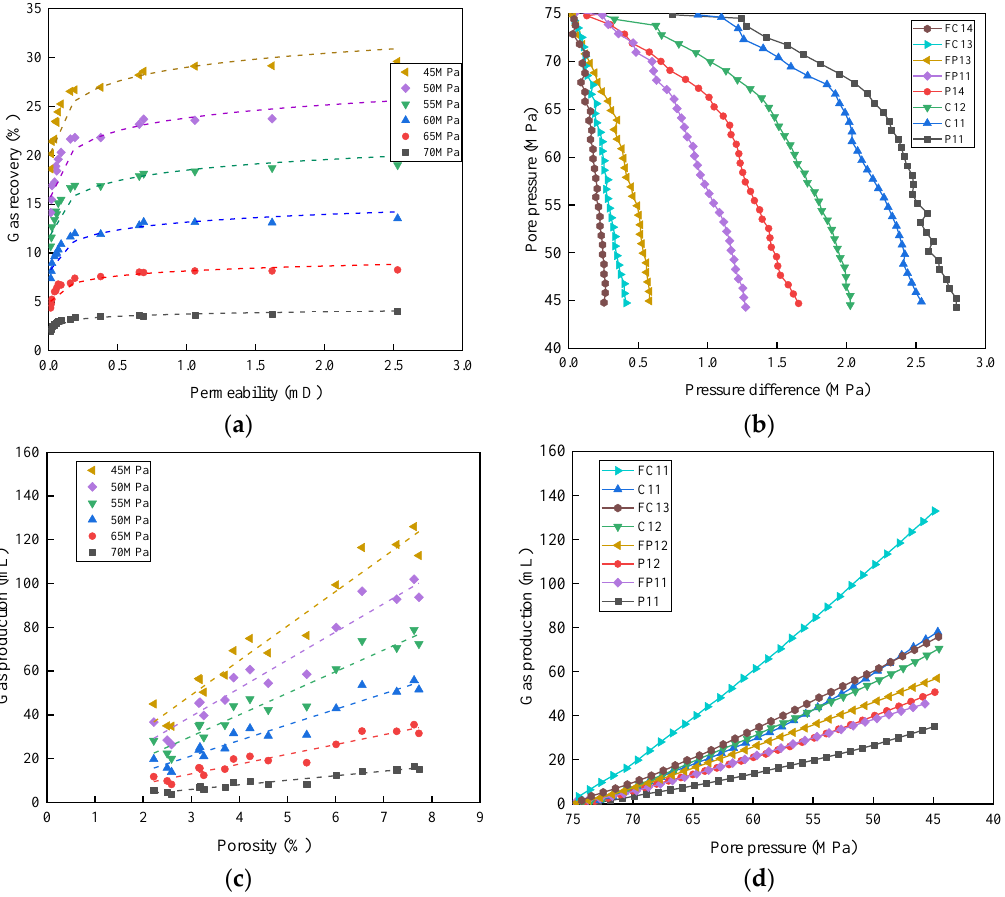
Figure 11. Gas recovery and production characteristics of different types of reservoirs: ( a ) gas recovery; ( b ) pressure difference between upstream and downstream; ( c ) gas production and ( d ) production under different pressure differences.